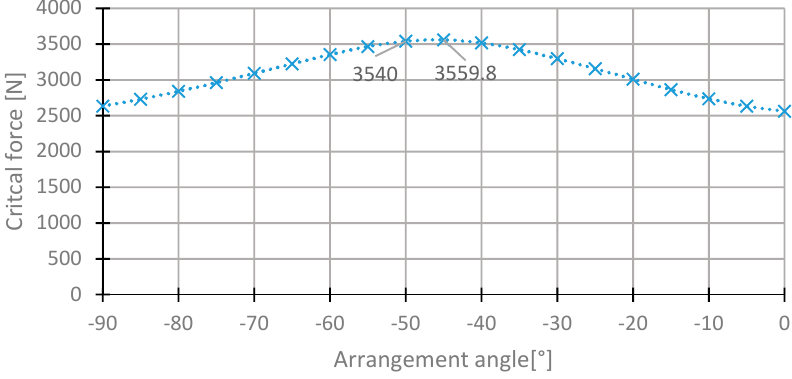
Figure 9. The critical force depending on the angle in the second laminate layer of the [45/ − 45/ − 45/45] arrangement for the change of the arrangement angle in the range from − 90° to 0°.